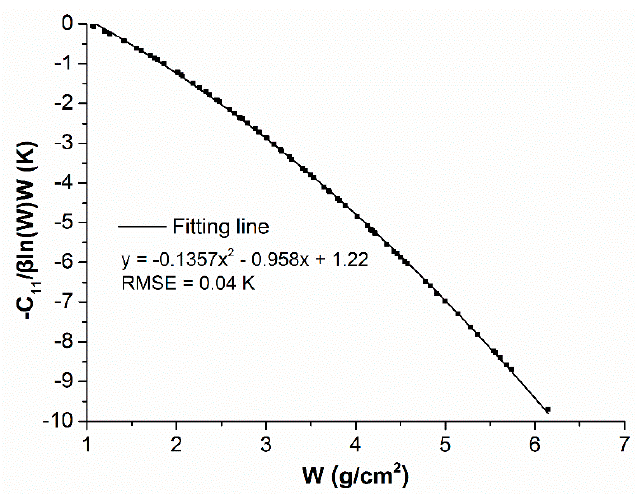
Figure 10. Plot of − C 11 / β ln(W)W in Equation (7) versus W (W: atmospheric water vapour content). The residual of constant C calculated by Equation (3) for W < 1 g/cm 2 and by Equation (8) for W > 1 g/cm 2 is shown in Figure 11, with RMSE = 0.86 K.